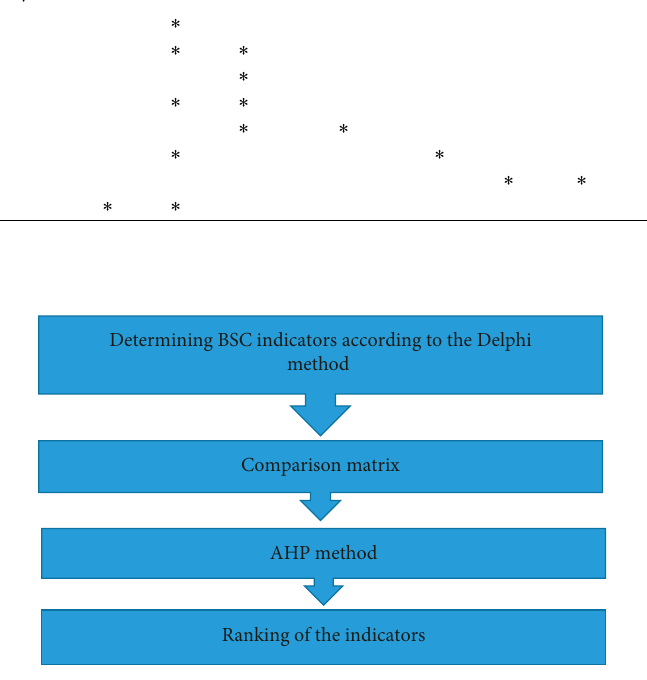
Figure 1: Conceptual